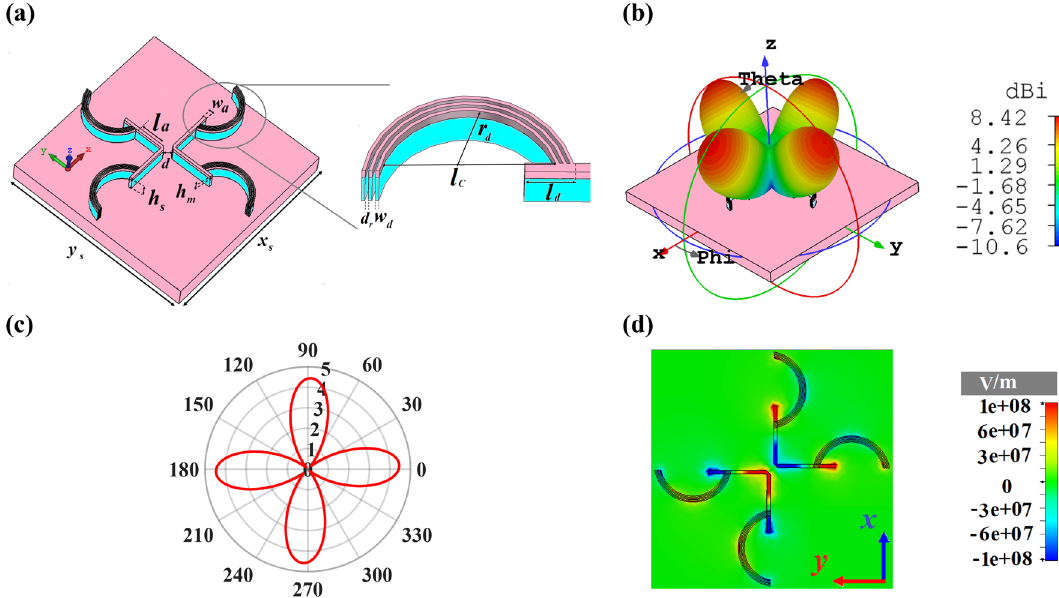
Figure 5. ( a ) 3D perspective view of quad-directional cross dipole nano-antenna with the director. ( b ) 3D and ( c ) 2D polar plot of directivity radiation patterns and ( d ) the z-component of electric field